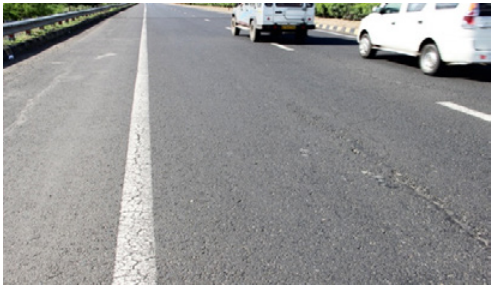
Figure 1. Surface condition evaluation on pavement section NE-1GJ02 at 32.00